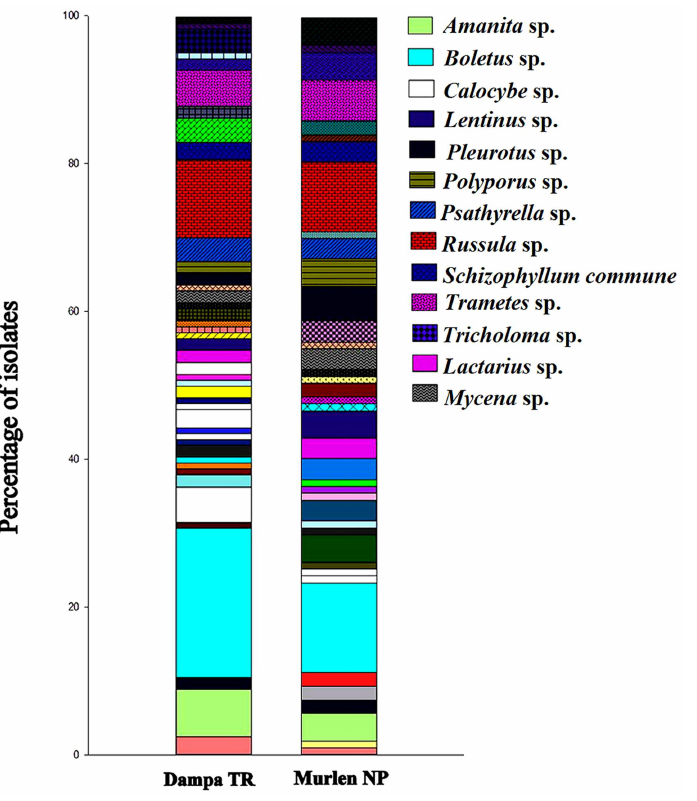
Fig 3. Relative abundance of wild mushrooms at the genus level in Dampa TR and Murlen